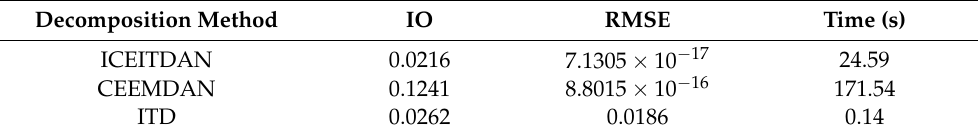
Table 1. Comparison indicators for the three